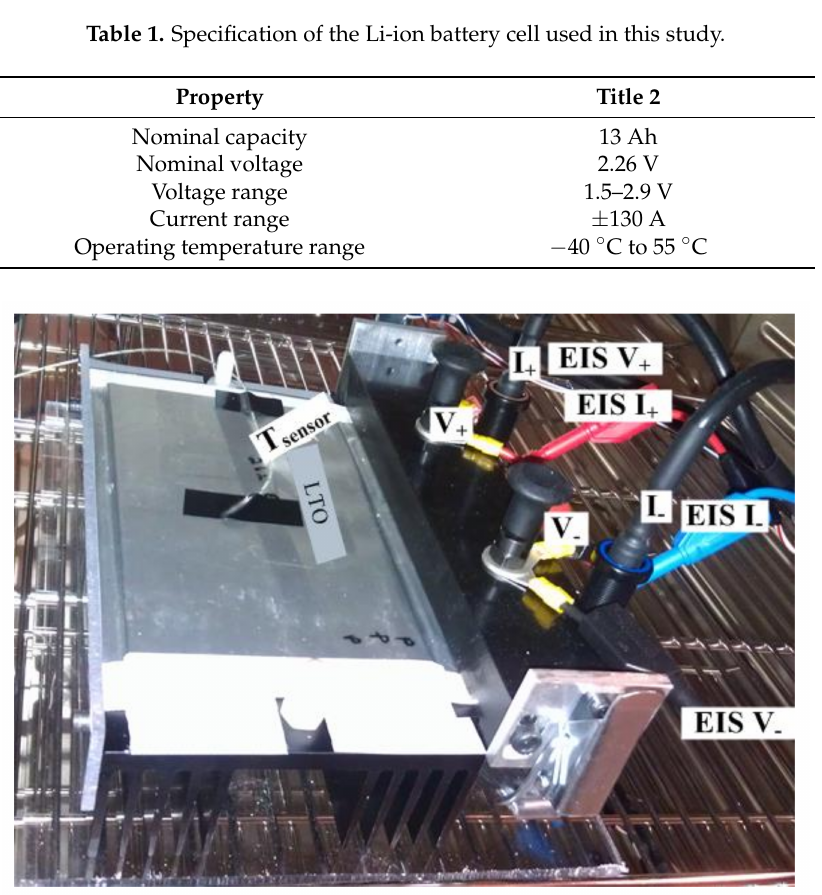
Figure 2. LTO-based Li-ion battery cell placed in a temperature